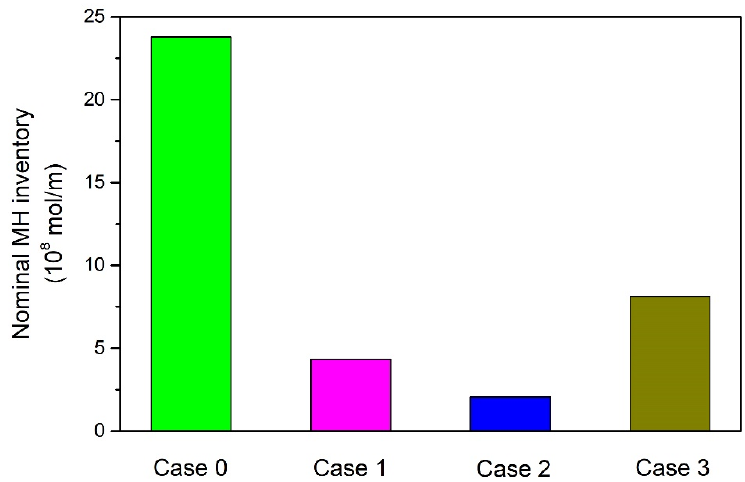
Figure 14. Nominal MH resource comparison among the four geological